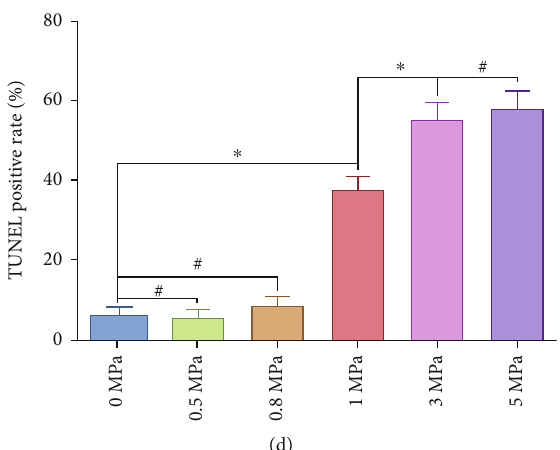
Figure 2: E ff ect of hydrostatic pressure on cellular survival of the rabbit notochordal NP and fi brocartilaginous inner AF: (a) fl uorescent TUNEL staining of the notochordal NP under graded hydrostatic pressure (200x); (b) statistic analysis of TUNEL positive rate of the notochordal NP under graded hydrostatic pressure; (c) fl uorescent TUNEL staining of the fi brocartilaginous inner AF under graded hydrostatic pressure (200x); (d) statistic analysis of TUNEL positive rate of the fi brocartilaginous inner AF under graded hydrostatic pressure. ∗ P < 0 : 05 . # P > 0 : 05 . Scale bar = 100 μ